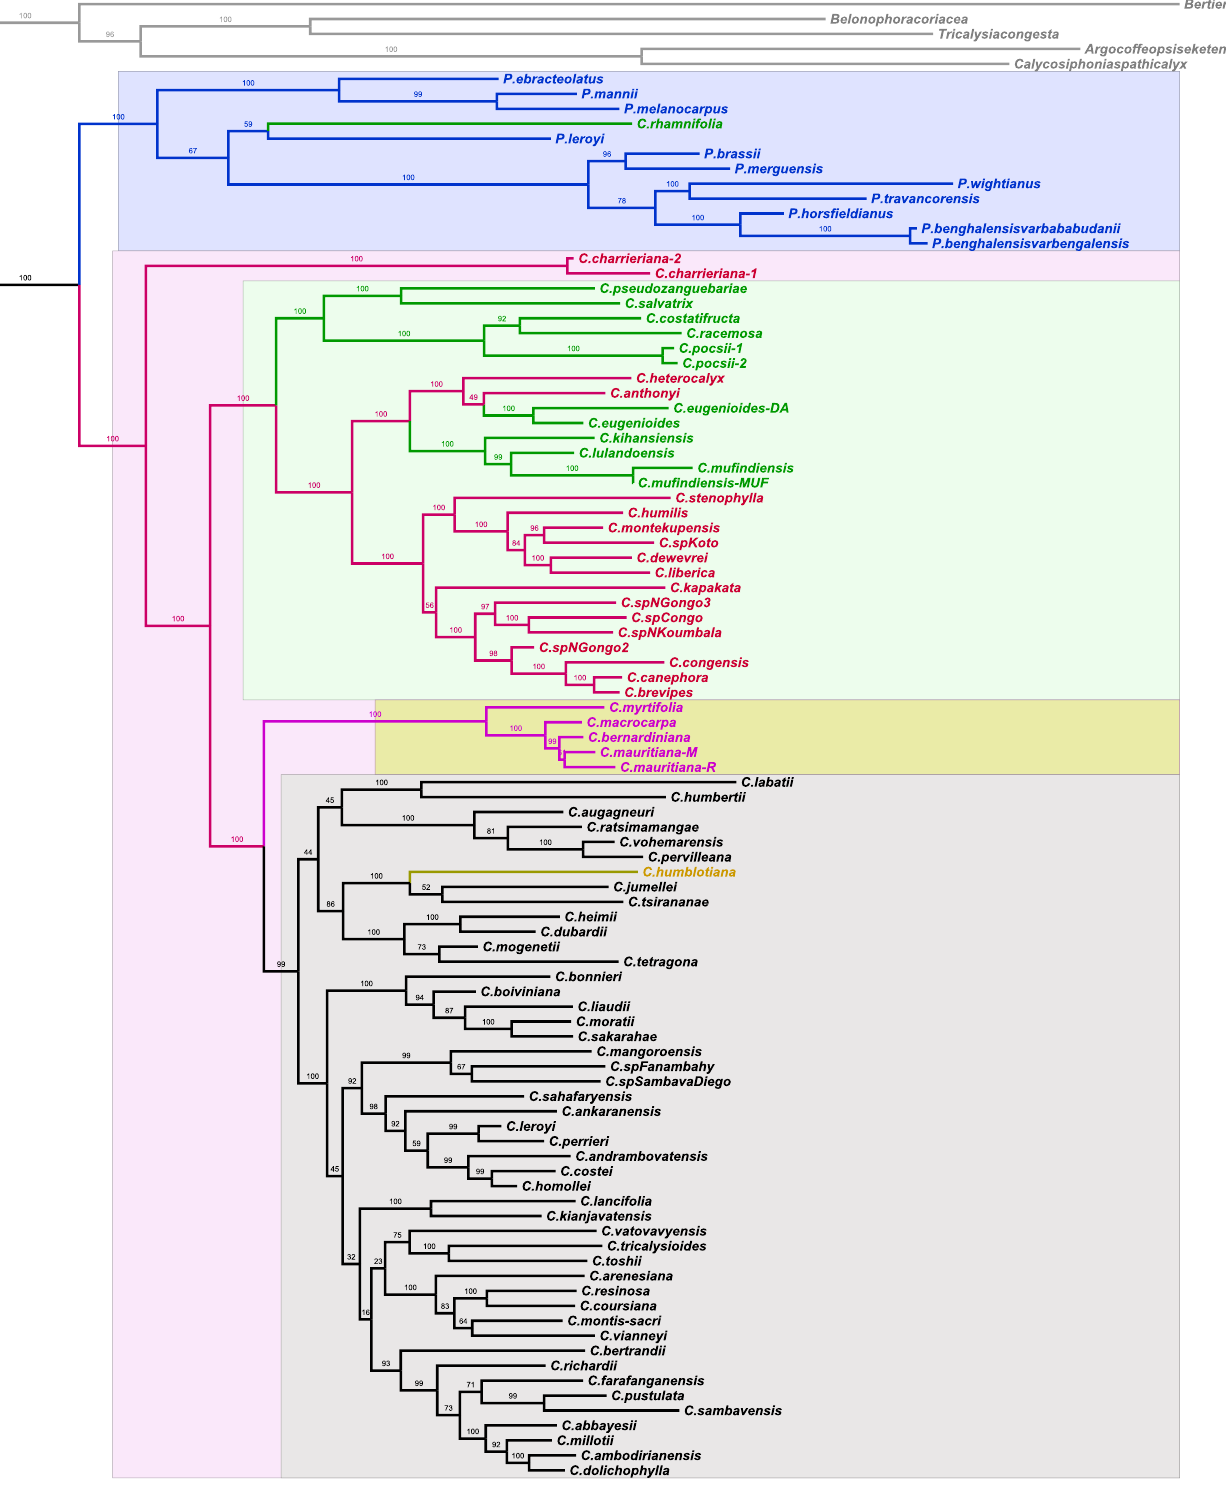
Fig 3. Maximum likelihood nuclear phylogeny of coffee trees. The molecular tree was based on 22,800 SNPs as described in [18] and a larger set of species (see S1 Table). Branch lengths are proportional to inferred nucleotide substitutions. The values at the nodes indicate the bootstrap support of each branch in percent. The main